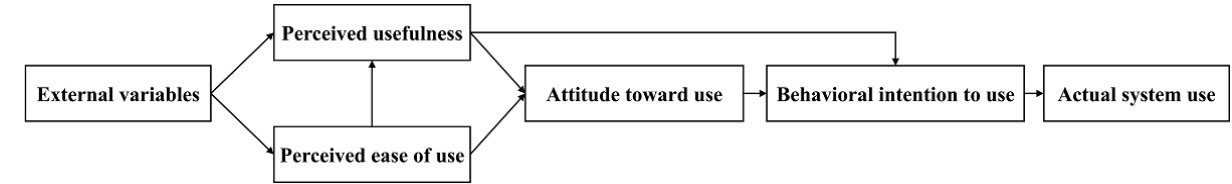
Figure 1. The framework of the technology acceptance